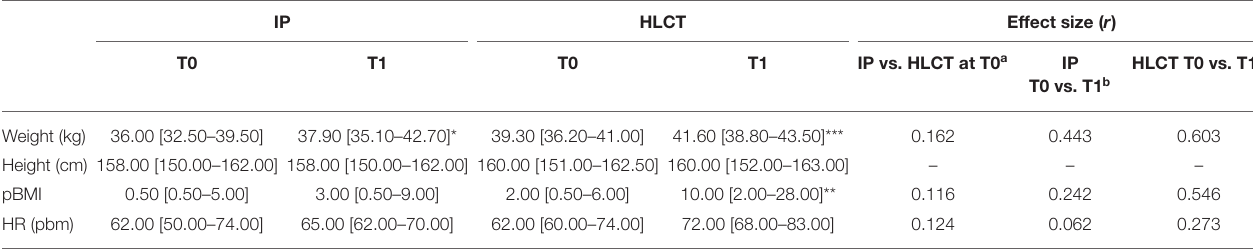
TABLE 2 | Clinical parameters at T0 and T1 in IP and HLCT